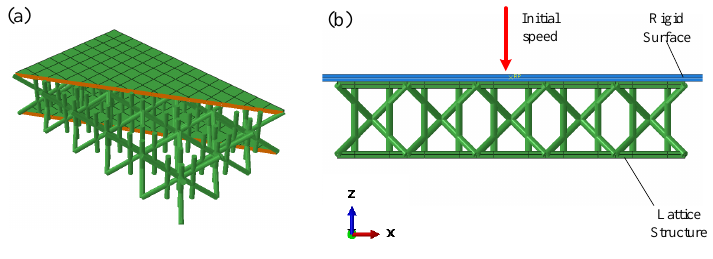
Figure 3. Impact analysis of BCC4IZ. ( a ) BCC4IZ specimen; ( b ) Analysis model.